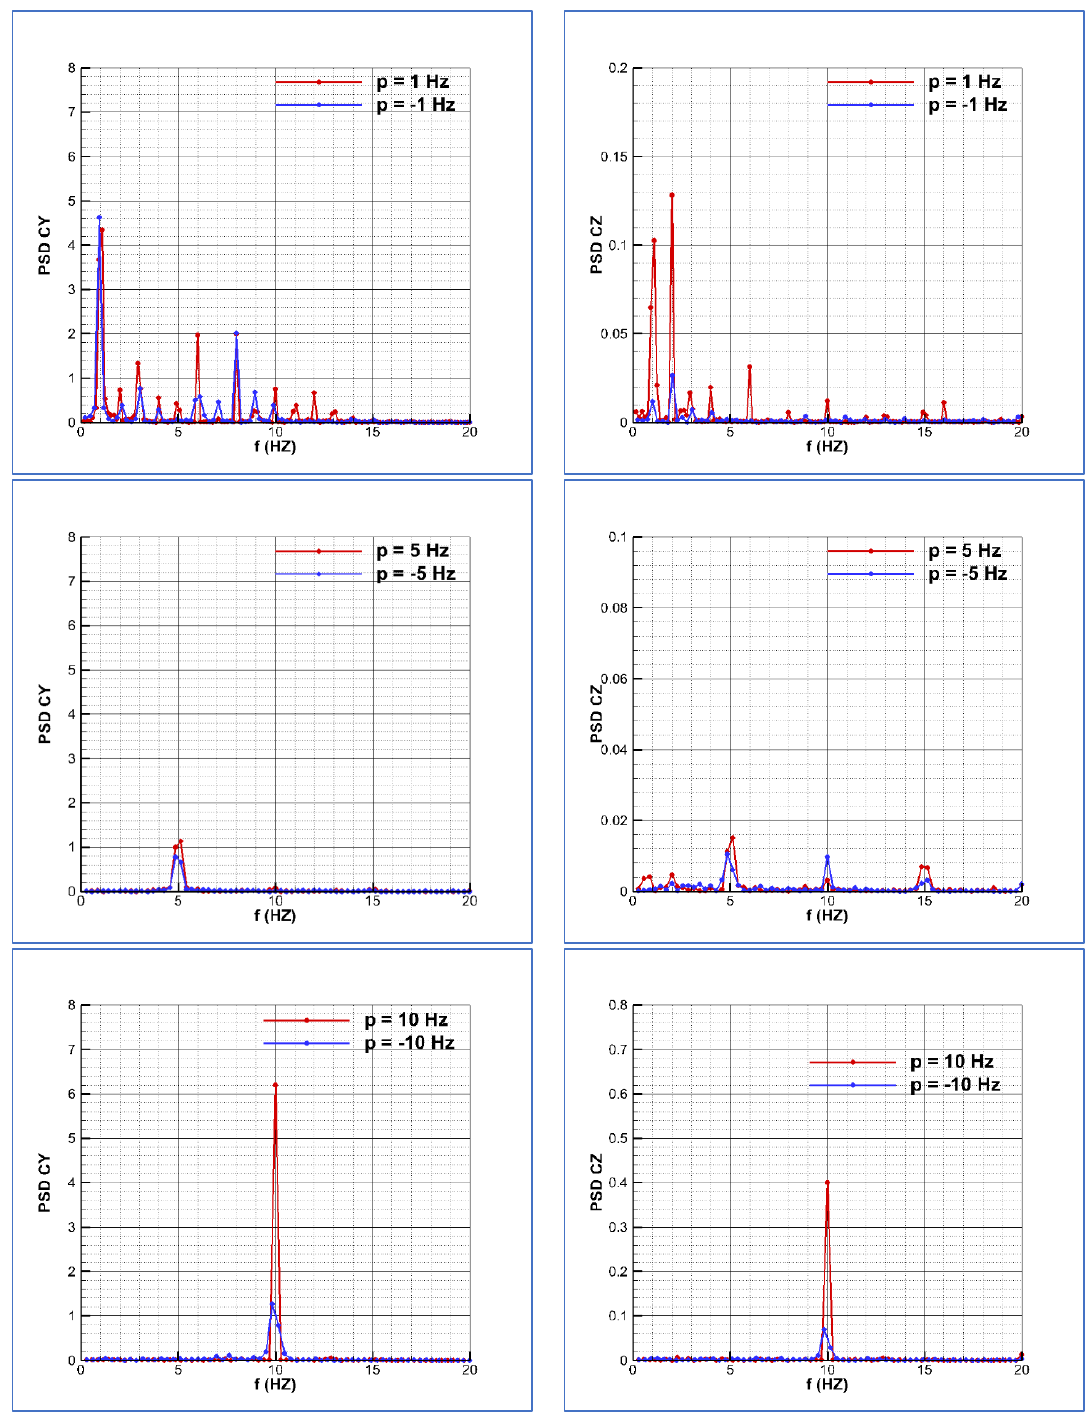
Figure 6. Power spectral analysis for the side ( left ) and normal ( right ) force coefficients. Ma = 0.2, Re =2 × 10 6 and α = 45 deg. Calculation with p = ± 1 Hz ( above ), p = ± 5 Hz ( middle ) and p = ± 10 Hz ( bottom ). Blue color: negative spin velocity. Red color: positive spin velocity.